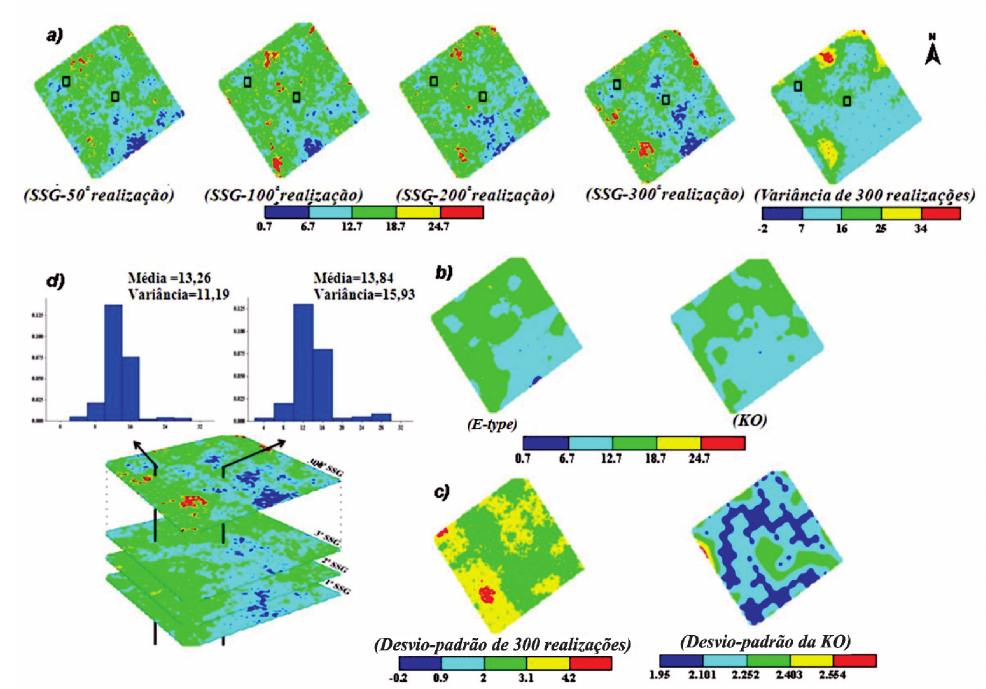
4. Mapas das realizações (50ª, 100ª, 200ª e 300ª) e variância de 300 realizações (a), mapas das estimativas E-type e KO (b), mapas do desvio-padrão de 300 realizações e da KO (c) e incertezas locais de dois pontos da área (d) dos teores de Hm na pedoforma côncava.